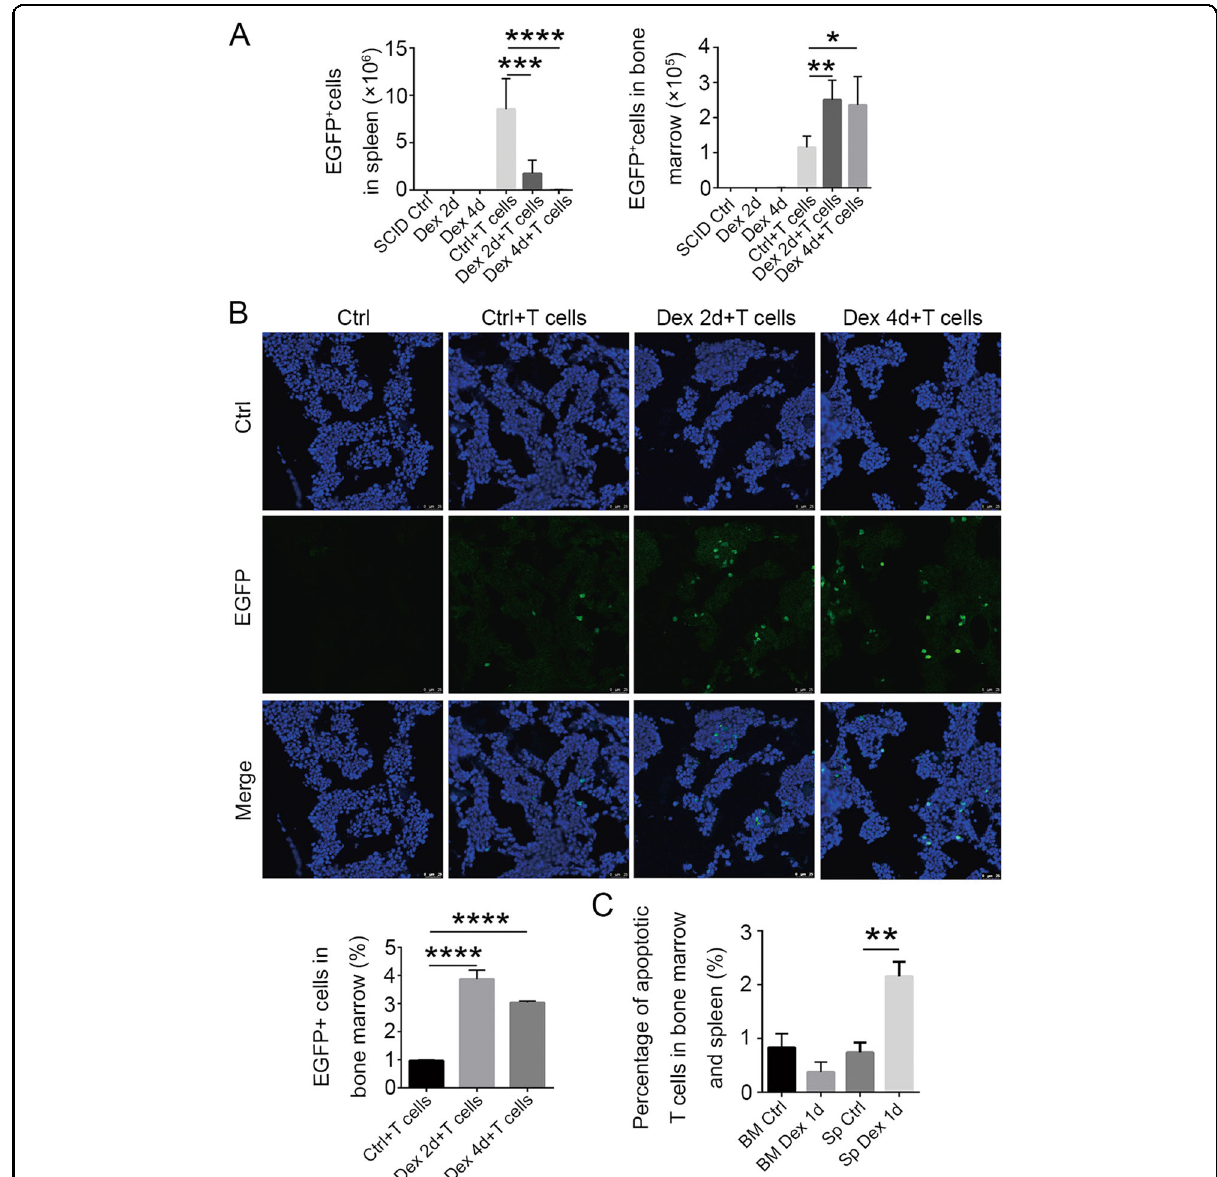
Fig. 6 T cells accumulate in bone marrow after GC treatment. A Splenic T cells were isolated from 10-week-old EGFP mice, and transferred into SCID mice. The splenic and bone marrow EGFP + cells from SCID mice were quantitated by fl ow cytometry at 2 and 4 days after Dex injection ( n = 3). B Fluorescence microscopy showing T-cell accumulation in bone marrow. Scale bar, 25 μ m. Statistical histograms are shown below, left. C Percentages of apoptotic T cells in spleen and bone marrow, as detected by fl ow cytometry after staining with 7-AAD and Annexin V ( n = 5). Bars represent mean ±